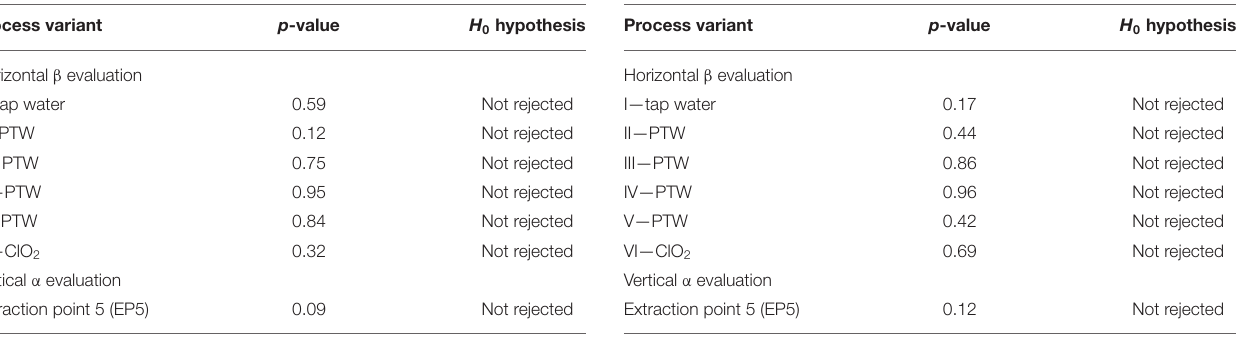
TABLE 2 | Statistical evaluation of storage day 0.